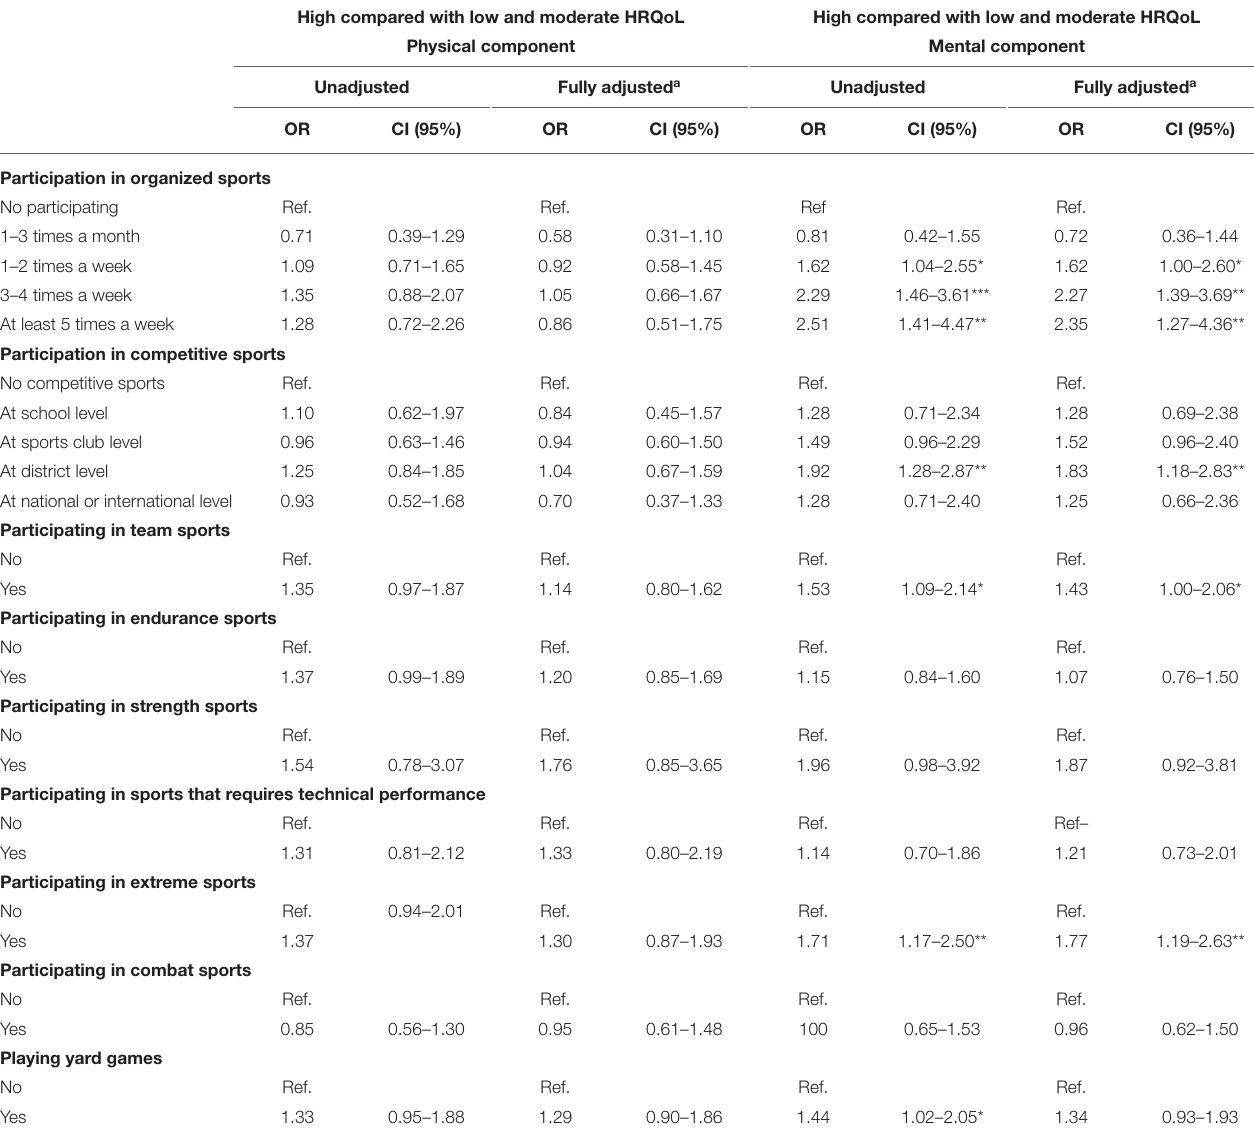
TABLE 4 | Odds ratios (OR) and 95% confidence intervals (CIs) separately for high compared with low and moderate scores in the physical and mental component summary of RAND 36 by variables describing sports participation at age 12 years. High compared with low and moderate HRQoL High compared with low and moderate